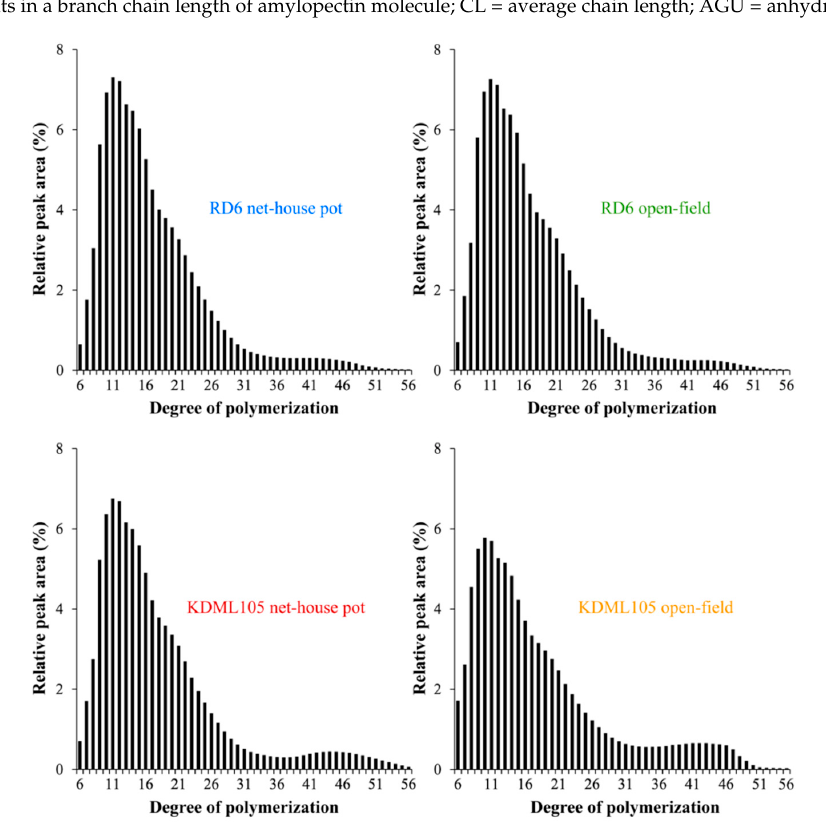
Figure 2. Amylopectin branch chain length distribution of grain starches from the two elite Thai rice cultivars grown in the net-house pot and open-field production systems. Table 6. Starch granule size distribution (volume %), median particle size [d(0.5)], and relative crystallinity of starch granule in the grain of the two elite Thai rice cultivars grown in the net-house pot and open-field production systems.